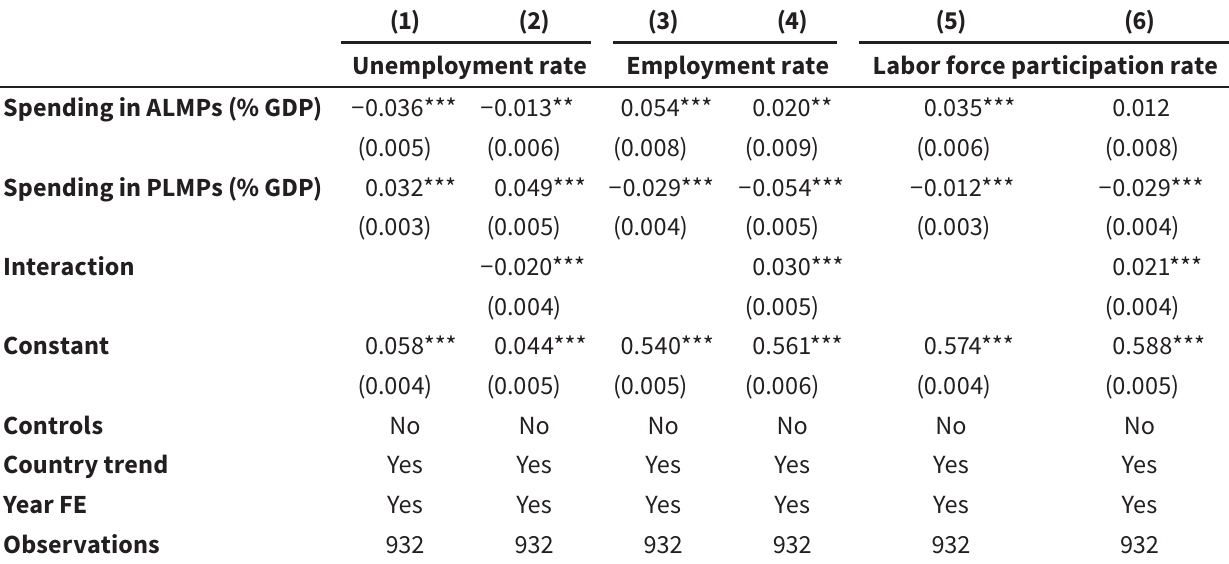
Note : The presented statistics are coefficient estimates and robust standard errors in parentheses for the panel model outlined in Section